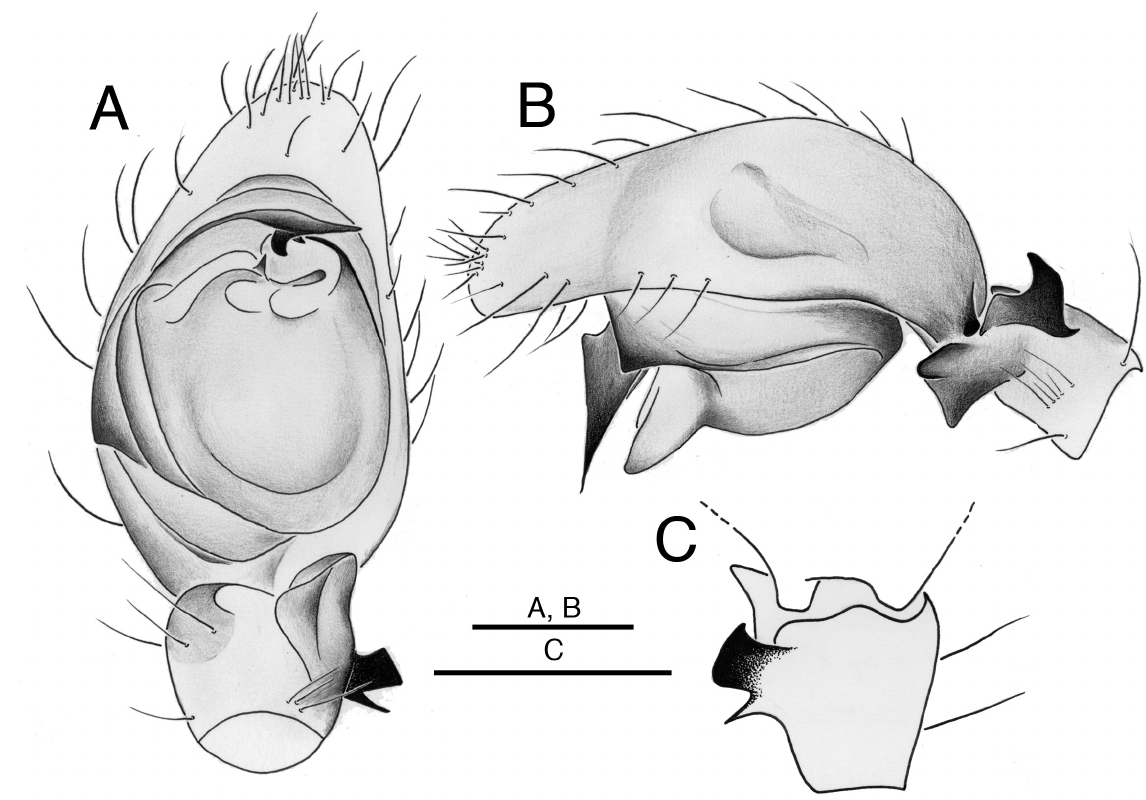
Fig. 10. Chumma tsitsikamma sp. nov., holotype, ♂ A . Palp, ventral view. B . As preceding, retrolateral view. C . Palpal tibia, dorsal view. Scale bars: 0.2